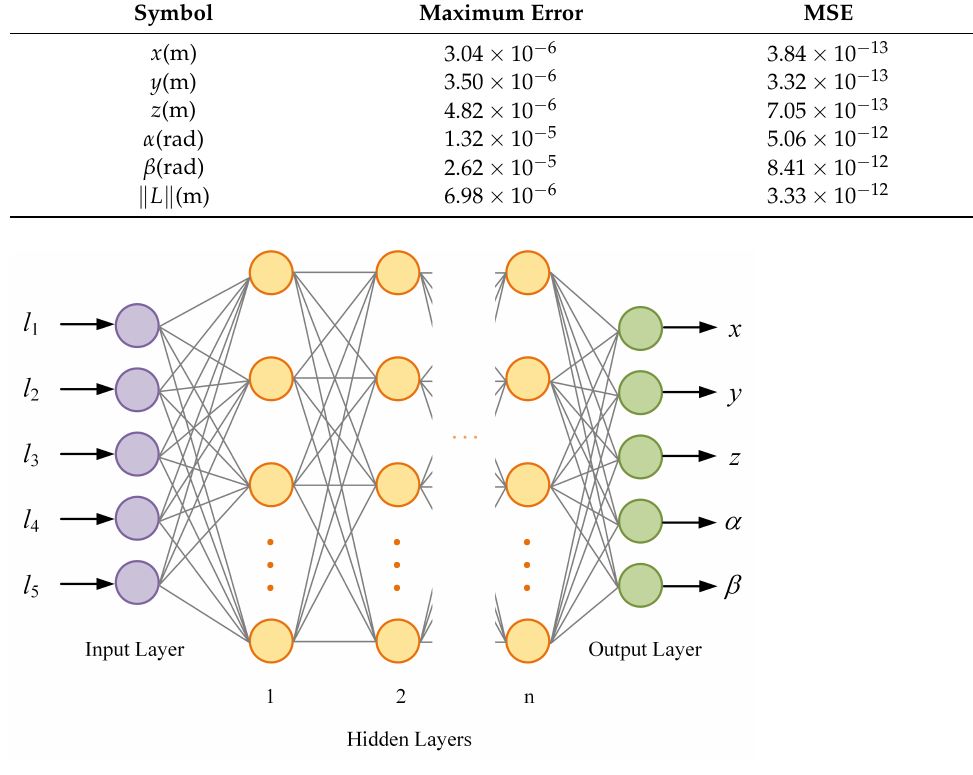
Figure 6. The structure of the Deep Neural Network.